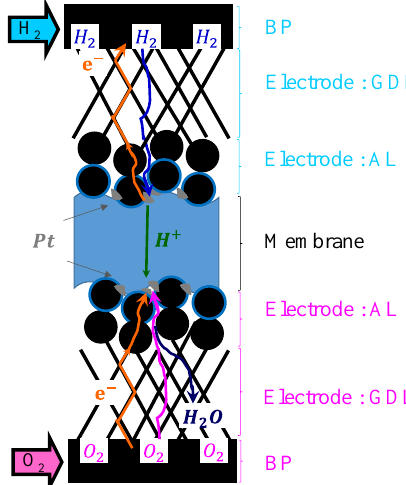
Figure 8. FC details: membrane-electrode assembly (MEA).